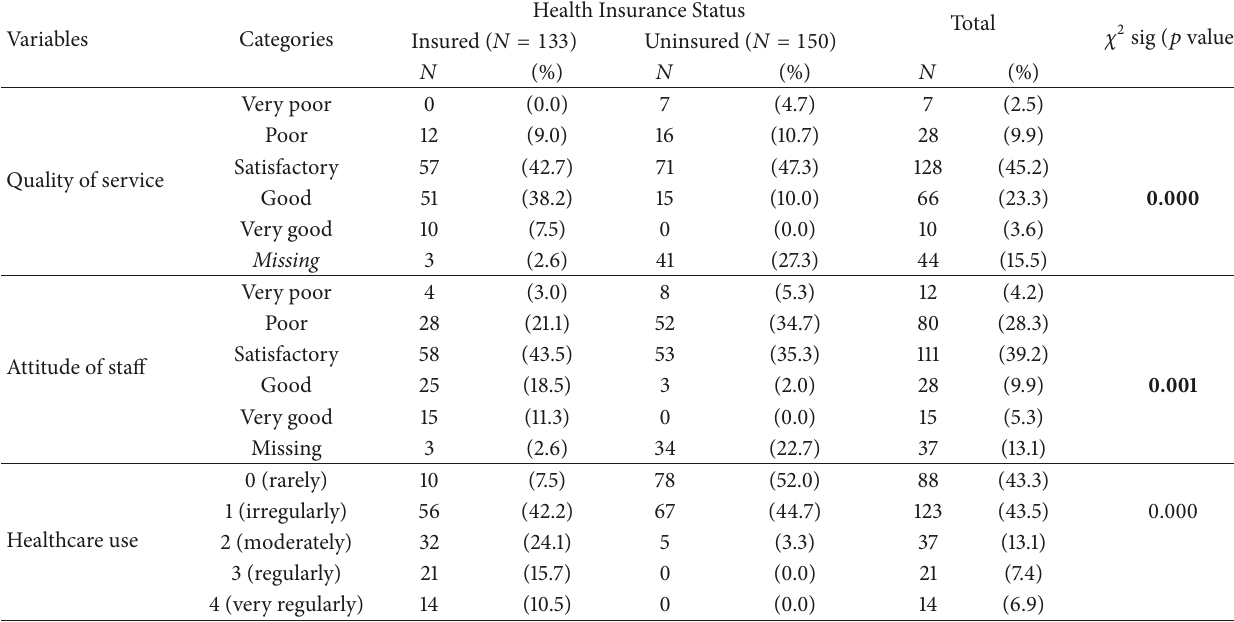
Table 2: Selected questions regarding participants’ healthcare